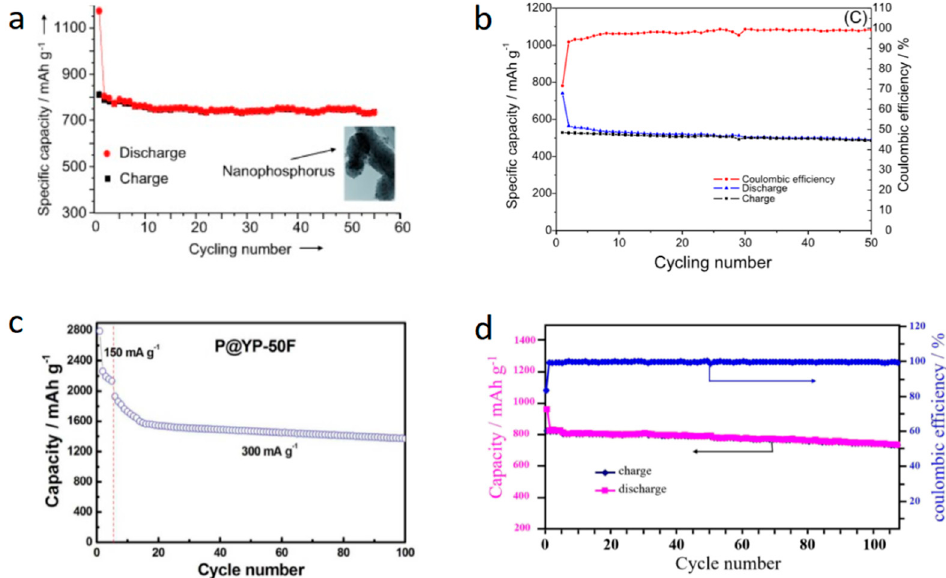
Figure 11. Cycle performance of the phosphorus / porous carbon composite in the electrolyte of 1m LiPF6 / EC + DMC + EMC [111] ( a ). Variations of coulombic e ffi ciency and charge / discharge capacity with cycles for the electrochemical performance of graphite / P@C composite [113] ( b ). Cycling performance of P@YP-50F [114] ( c ). Cycling performance of the red phosphorus composite electrode in rechargeable lithium batteries. The electrode disk is φ 7 mm diameter, equal to 0.38 cm 2 . The loading of the red phosphorus composite is 5.72 mg cm − 2 [115] ( d ). Reproduced by permission of Elsevier, The Electrochemical Society, Wiley and Springer.